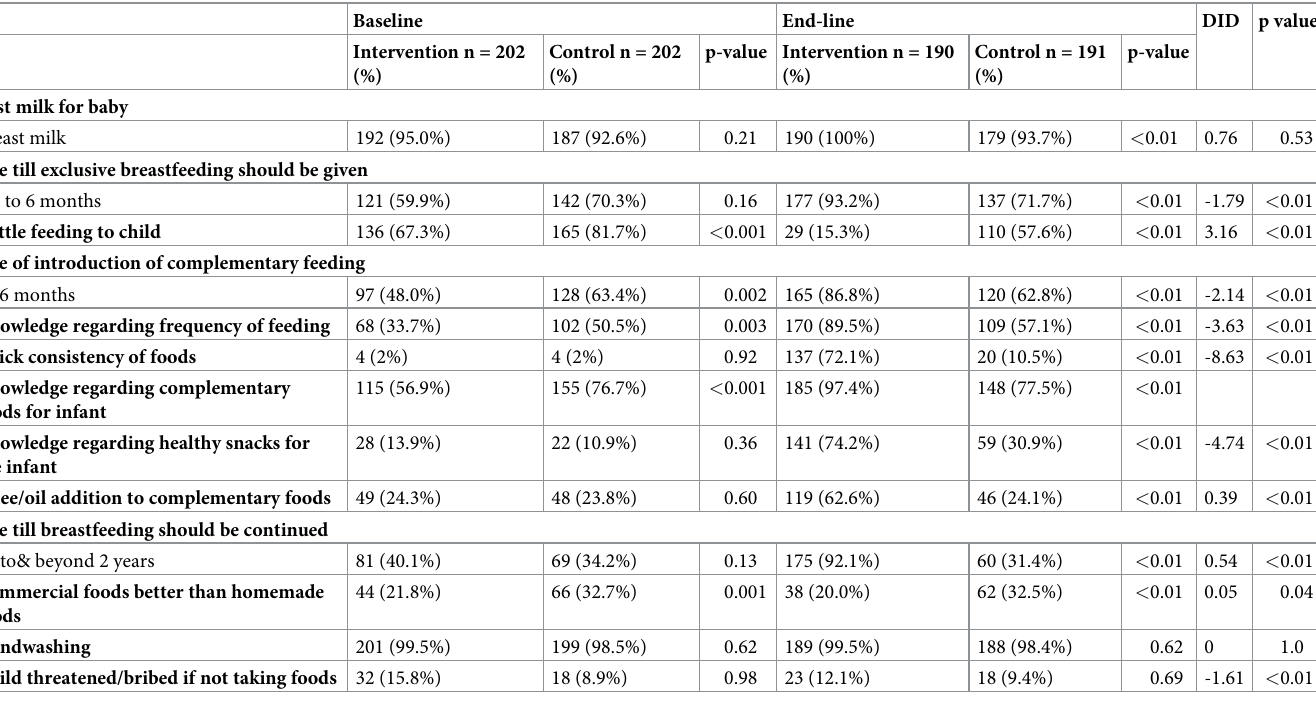
Table 4. Comparison of baseline and end line maternal knowledge regarding the feeding of infants between intervention and control group.